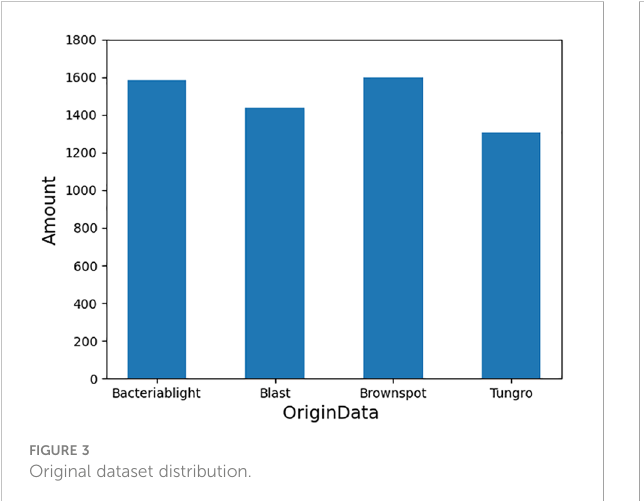
FIGURE 3 Original dataset